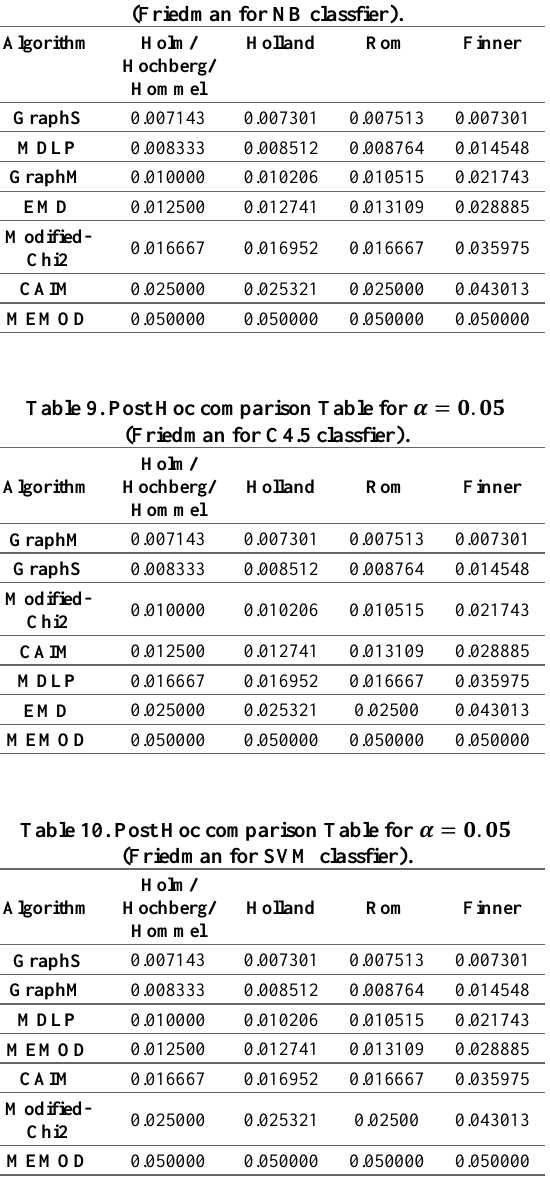
Table 8. Post Hoc comparison Table for 𝜶 = 𝟎.𝟎𝟓 (Friedman for NB classfier).